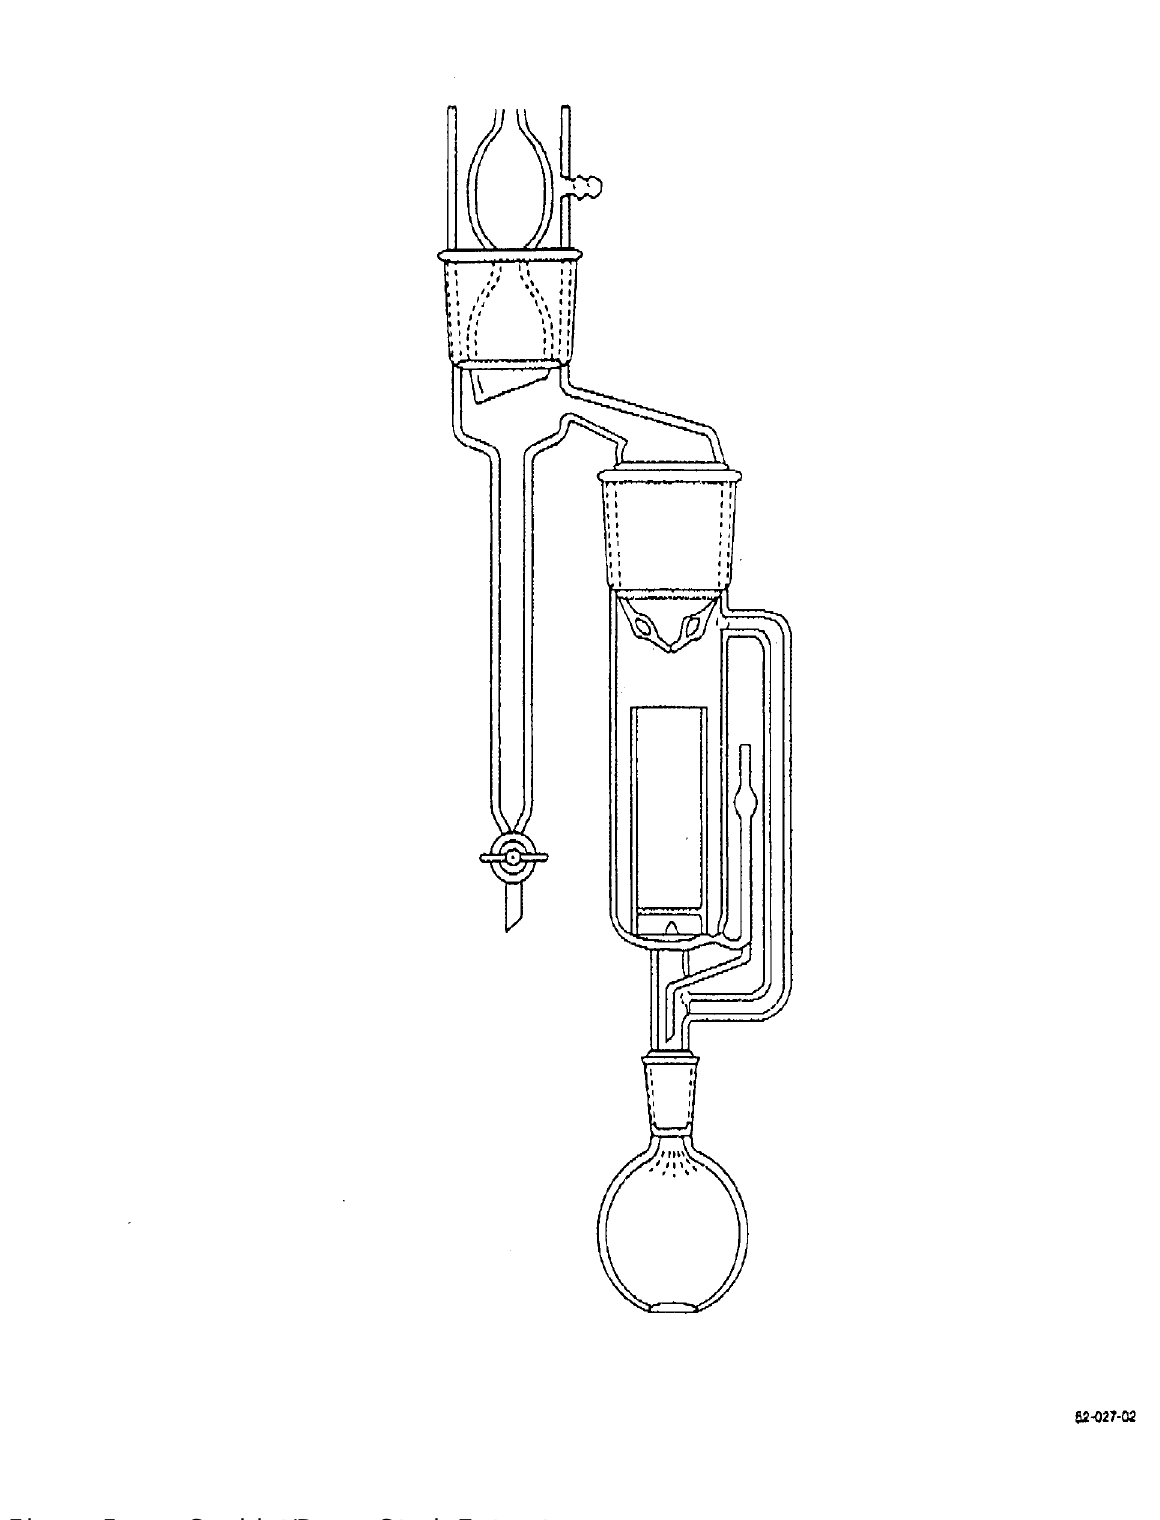
Soxhlet/Dean-Stark